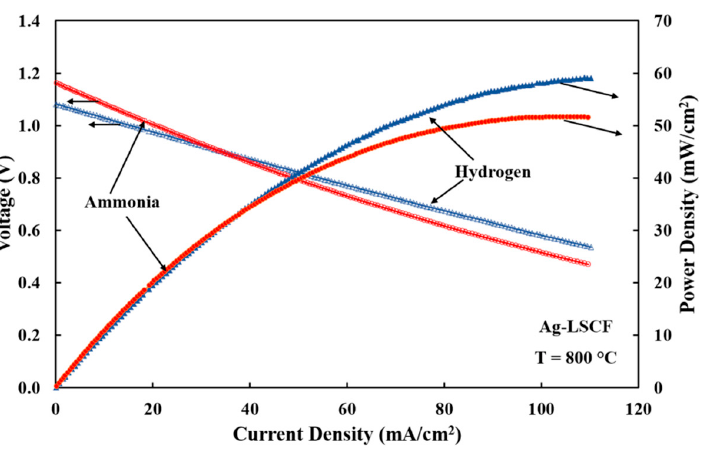
Figure 9. Voltage-current-power density characteristics of Ag-LSCF//YSZ//GDC/LSCF cell with hydrogen (hydrogen = 75 mL/min, air = 75 mL/min) and ammonia fuels (ammonia = 50 mL/min, air = 75 mL/min) at 800 °C.